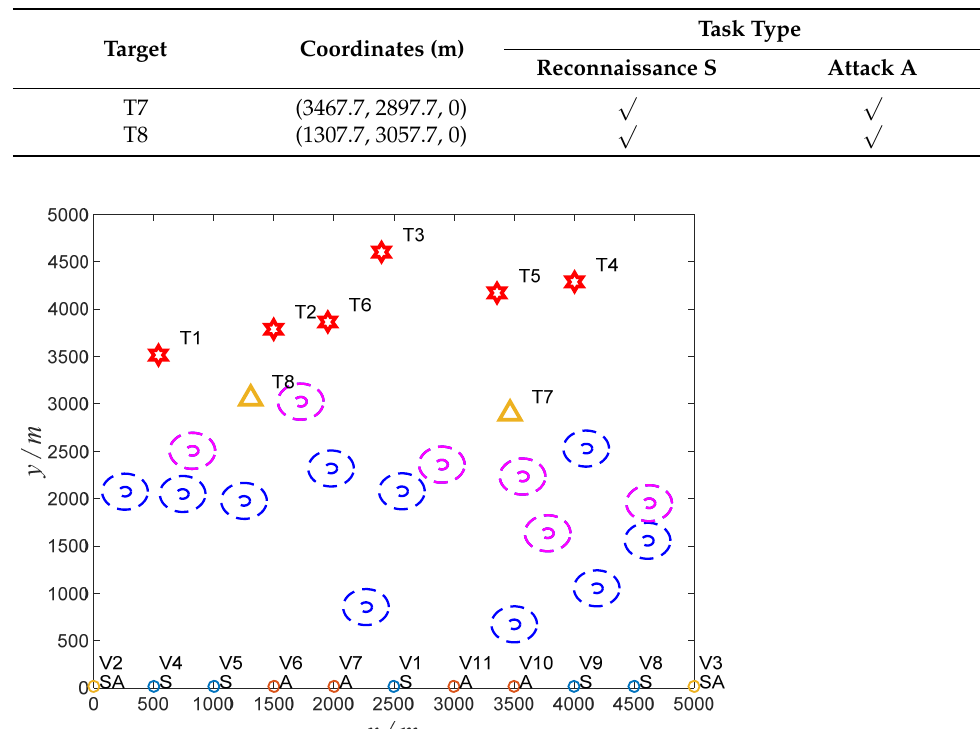
Figure 11. ( a ) The execution sequence of the UAV swarm; ( b ) the diagram of the UAV swarm per- forming tasks.